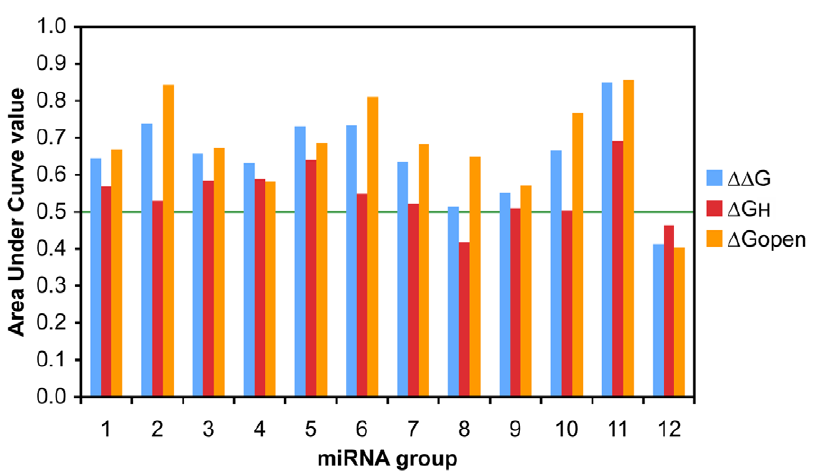
Figure 3. Discrimination between sites with and without evidence of AGO interaction. AUC values are shown for the three energy types in the duplex formation steps: DD G, D G H , and D G open for each miRNA group containing one or more of the 20 most highly expressed miRNAs in the same cell line and the miRNAs that shared their 5 9 end sequences. Only 6-mer sites were considered. The line at the AUC value of 0.5 indicates random performance.